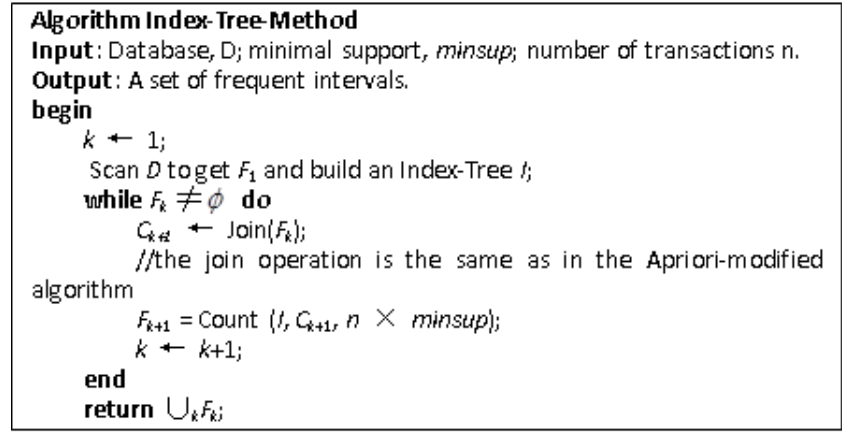
Fig. 8 Algorithm index-tree method.